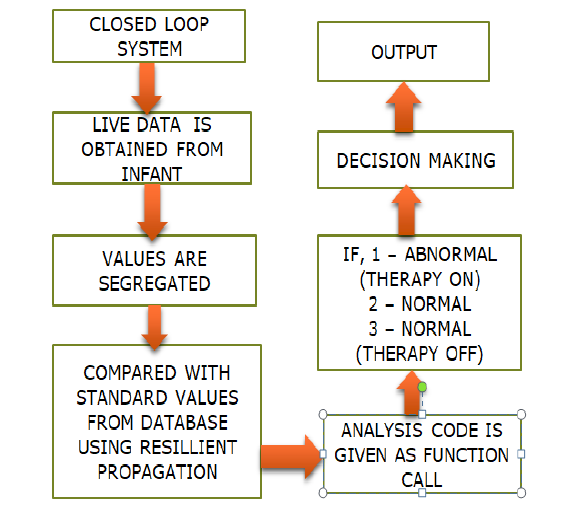
Fig 3: Flow Diagram of process When the program is run, a pop up box appears with either numbers ‘1’, ‘2’ or ‘3’. ‘1’ denotes abnormality and the therapy is ON, ‘2’ denotes that the condition is normal and ‘3’ denotes that the condition has come back to normal and the therapy is OFF.